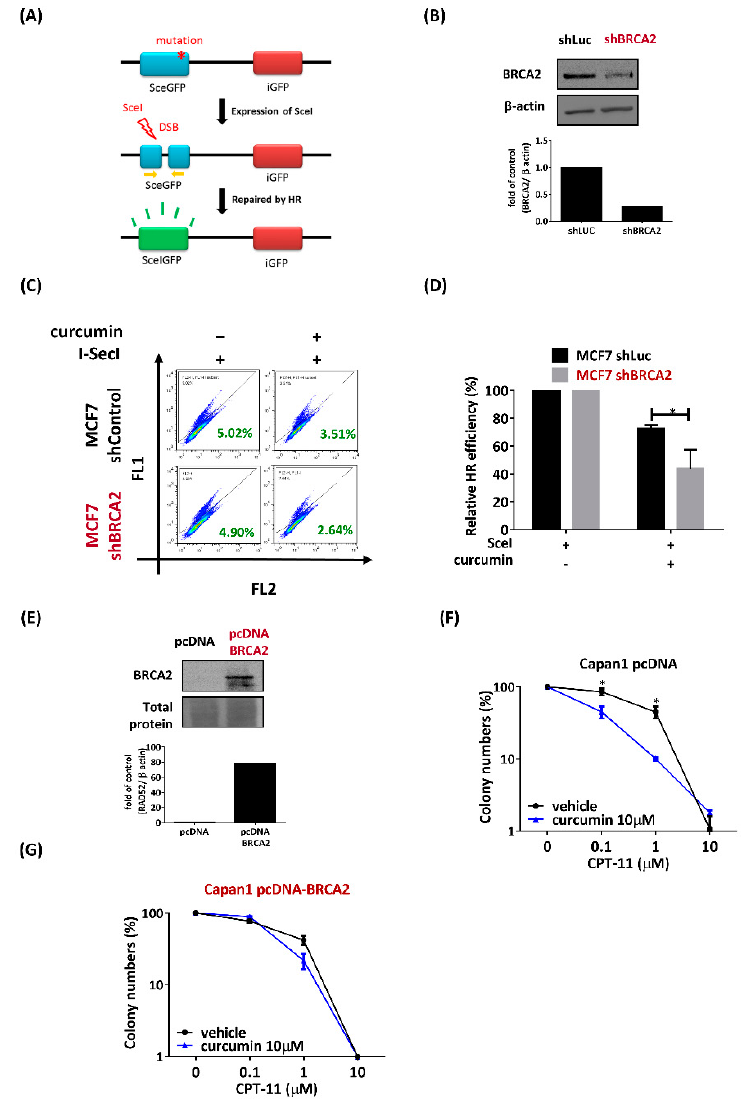
Figure 5. Curcumin decreased the sensitivity to CPT-11 in Capan1 cells that overexpress exogenous BRCA2. ( A ) The scheme illustrates the consequences of I-SceI-induced DSBs in DR-GFP. pSceI-GFP is a truncated GFP coding region that contains an I-SceI cutting site (blue box). The cleavage of the I-SceI cutting site can be repaired by homologous combination with a downstream GFP donor (red box) and results in GFP-positive cells (green box). ( B ) Immunoblot analysis of BRCA2 was performed to confirm knockdown. Bottom: quantification of the immunoblotting result. ( C ) Curcumin decreased HR in the MCF7-shBRCA2 cell line. MCF7-shRNA cells were cotransfected with I-SceI and DR-GFP plus with or without 20 µ M curcumin. Forty-eight hours later, the cells were analyzed by flow cytometry to determine the percentage of GFP-positive cells. ( D ) The bar graph shows the mean percentage of GFP-positive cells. All values are moralized to cells that were transfected with control shRNA or shBRCA2 without curcumin treatment. ( E ) BRCA2-deficient Capan1 cells were transfected with pcDNA or pcDNA-BRCA2 plasmid. Cell samples were taken and processed for immunoblot analysis using a BRCA2 antibody. Bottom: quantification of the immunoblotting result. ( F , G ) Quantification of colony numbers from the clonogenic assay (data not shown). After transfection with the pcDNA or pcDNA-BRCA2 plasmid, Capan1 cells were seeded in six-well plates and then grown in media containing CPT-11 alone or combined with curcumin for 10-14 days. The detailed procedures are described in the Materials and Methods section. Asterisks (*) indicate significant differences between CPT-11 and combined CPT-11 and curcumin cells (* p < 0.05).